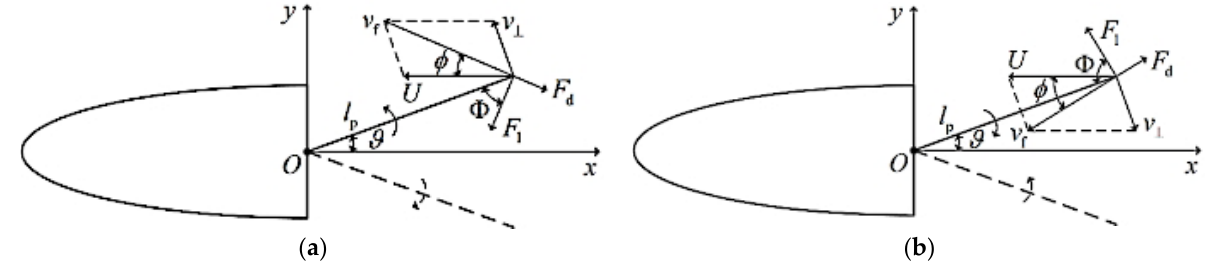
Figure 3. Force analysis of undulatory motion of fish robot: ( a ) caudal fin swings to both sides from the middle position ( x -axis); ( b ) caudal fin swing back to the middle position ( x -axis) from both sides.